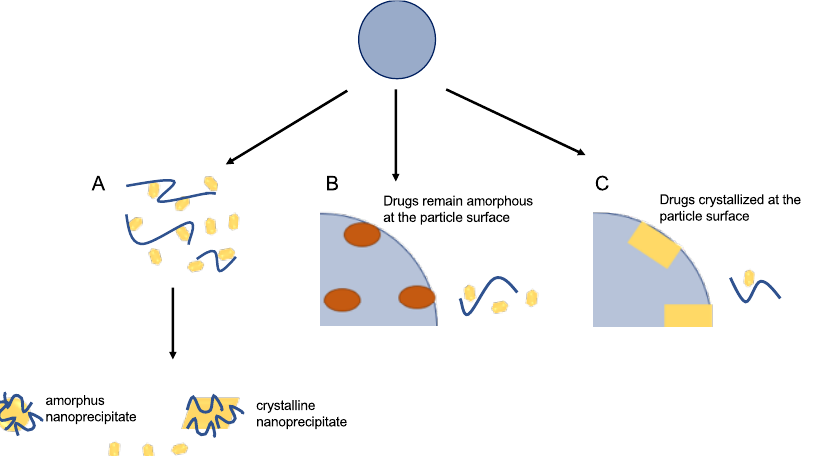
Figure 8. Three possible scenarios of drug dispersion from solid dispersions. ( A ) Particles rapidly dissolve and release the drug into a highly supersaturated solution; ( B ) drug and polymer are gradually released; and ( C ) drug and polymer are gradually released but the drug is present in a crystals state. Adapted from data presented originally in Ref [74].